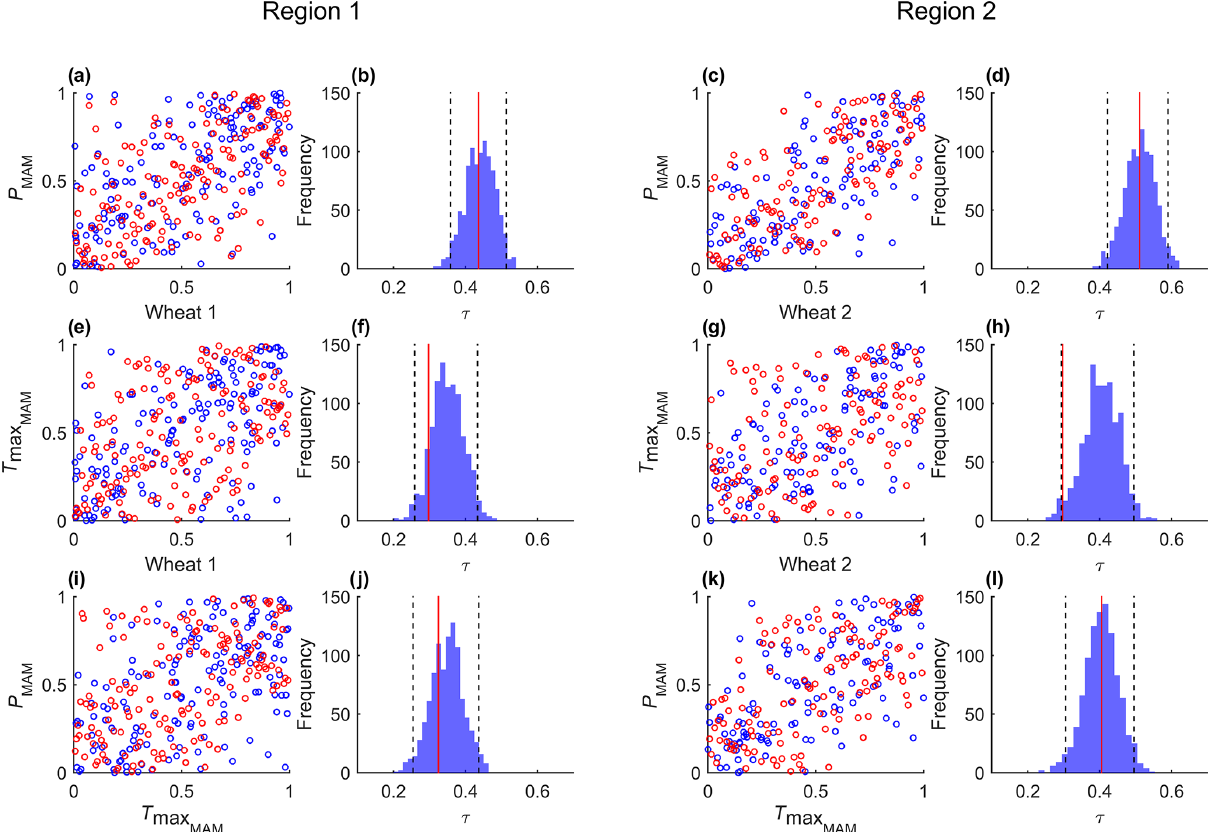
Figure 5. Scatterplots of copula-based samples (blue) compared with ranked observations (red) of crop anomalies with climate variables P MAM and T max (a, c, e, g) and P MAM against T max (i, k) , for both regions. The histograms (b, d, f, h, j, l) correspond to MAM MAM the Kendall rank correlation of each pair based on 10000 simulations with the same sample size of the observational sample. The 95% confidence intervals are shown with dashed lines. The red lines indicate the Kendall rank correlation of the observations.